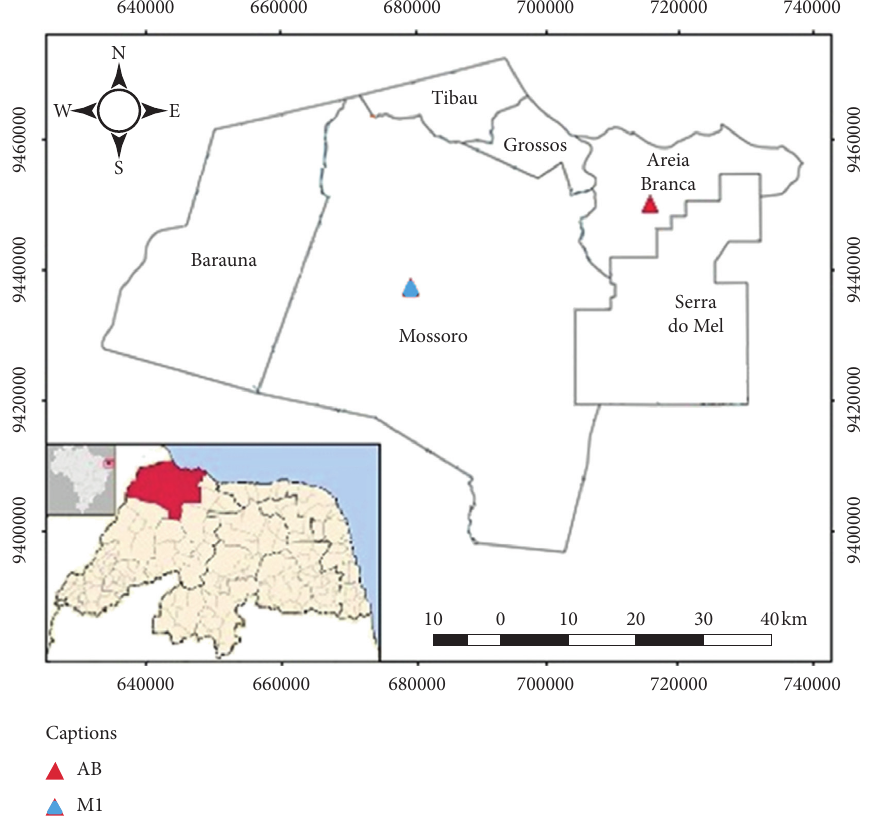
Figure 1: Location of collection